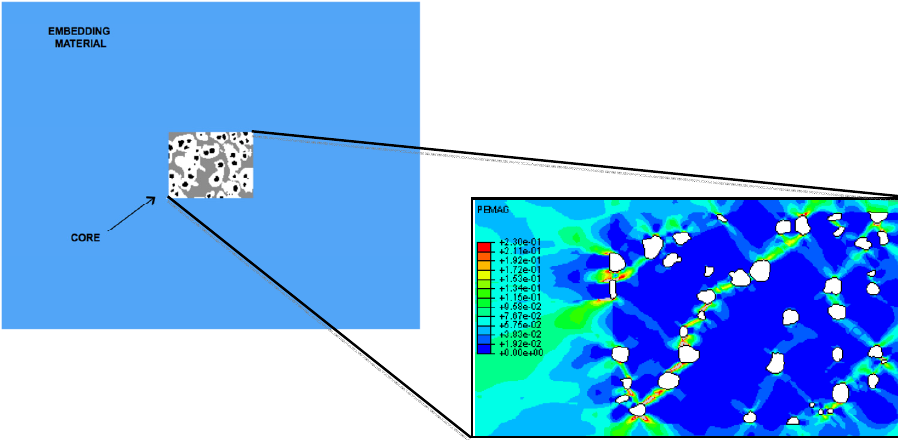
Figura 11: Modello tipo Embedded cell , e distribuzione della risultante della deformazione plastica in seguito all’applicazione di un carico in direzione